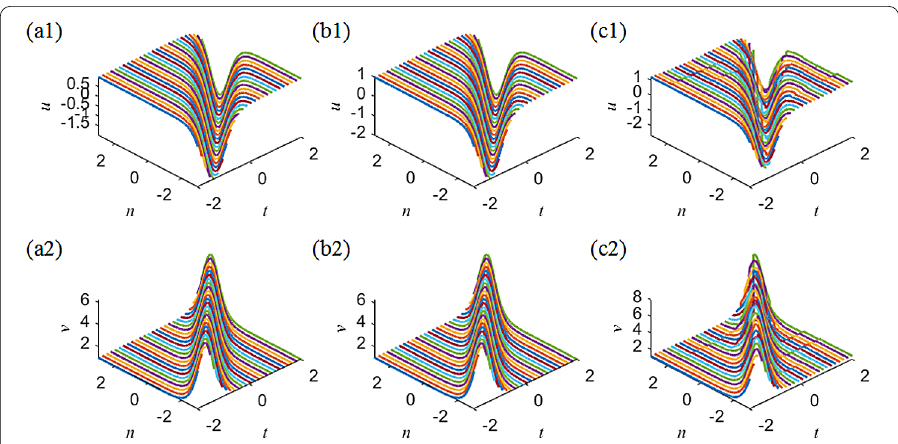
Figure 13 One-soliton solution (52) with the parameters r 1 = –1, r 2 = 1, λ 1 = –1, λ 2 = –4 when N = 1. ( a ) Exact solution; ( b ) Time evolution using exact solution (52) as an initial condition; ( c ) Time evolution using exact solution (52) perturbed by a 20% noise as the initial condition